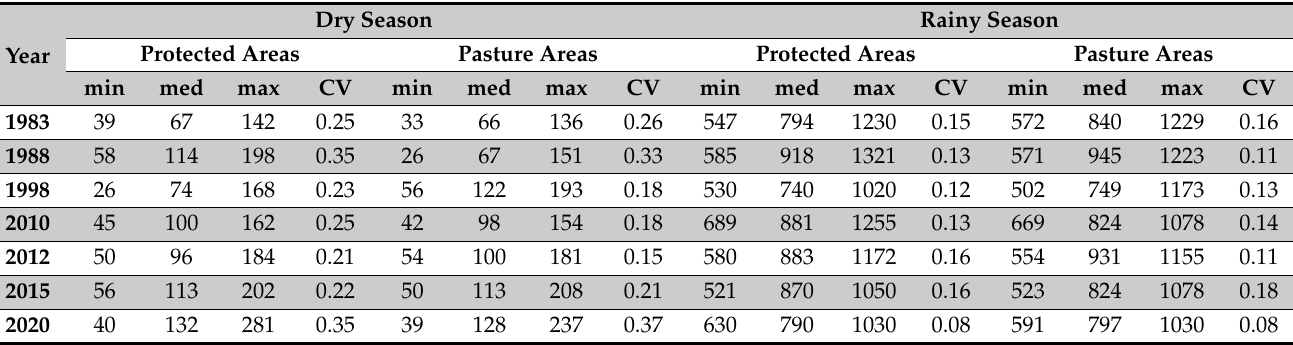
Figure 13. Spatialization of the Sen’s Slope for rainfall for the dry season in Rondônia for the years 1981 to 2020 using CHIRPS data for protected and pasture areas. Summary statistics of the raster layers are presented in Table 6. Table 6. Descriptive statistics of precipitation (mm.year − 1 ) for years 1983, 1998, 2010, 2015 and 2020 presenting minimum, medium and maximum values for protected and pasture areas.